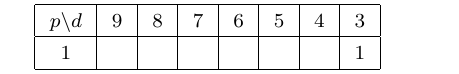
Table 36 . Number of E